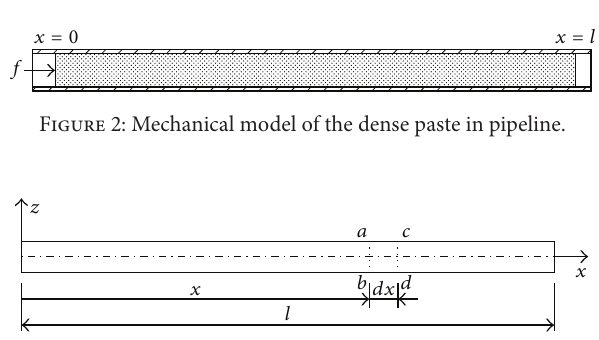
Figure 3: Geometrical diagram of paste